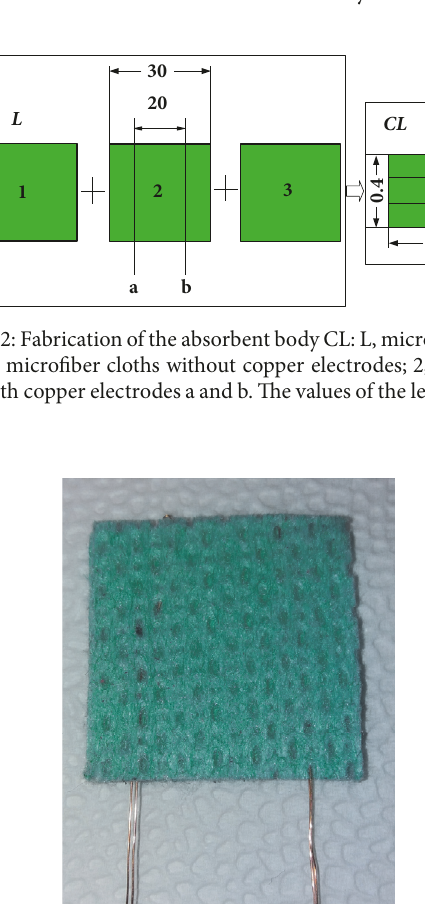
Figure 3: Resistor body consisting from the microfiber cloth (turquoise) and two parallel copper wires (reddish brown). Dimen- sions are the same as in Figure